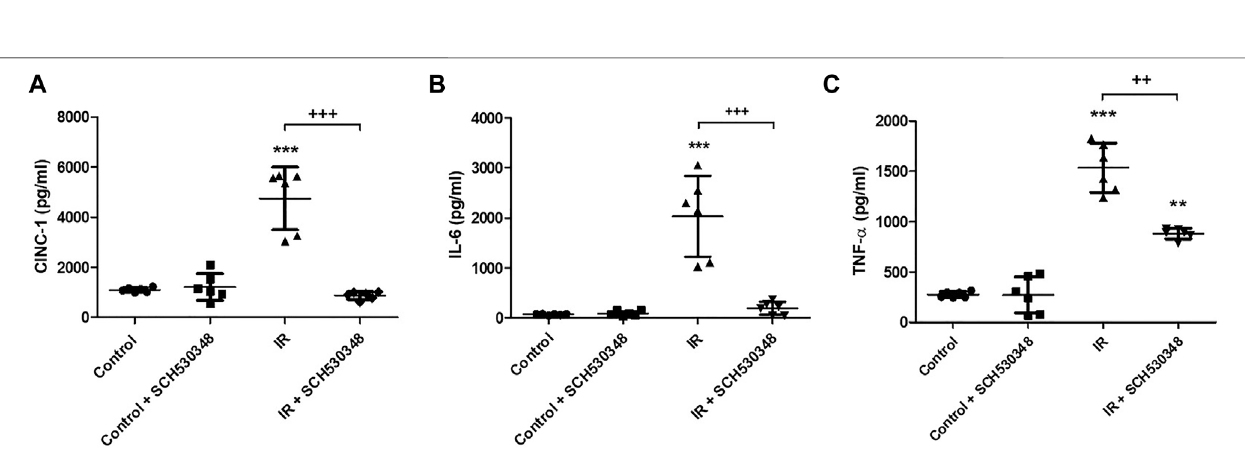
Frontiers in Pharmacology |